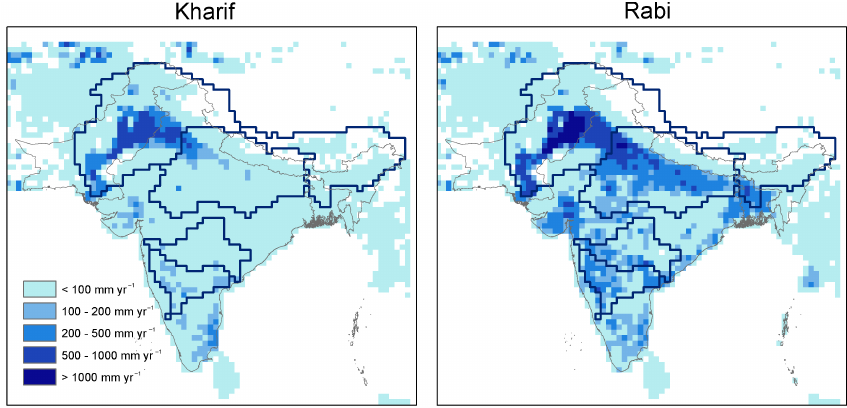
Figure 6. Gross irrigation-water demand for kharif (June to October) and rabi (November to March) cropping seasons, with selected river basins (Indus, Ganges, Brahmaputra).